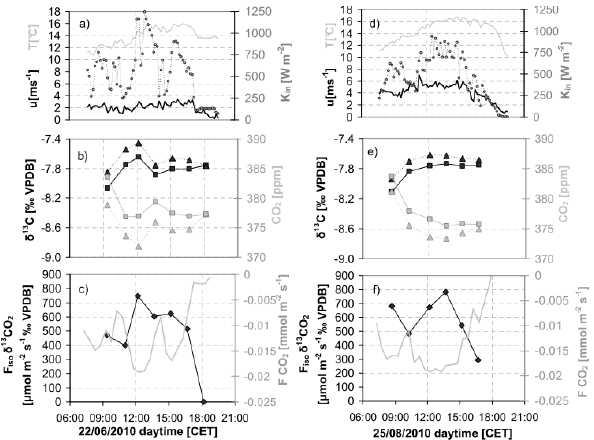
Figure 4. Incoming shortwave radiation K in (grey dashed line with circles), temperature T and wind velocity u (bold black line) are illustrated in (a) and (d) . Dark upward triangles in (b) and (e) repre- sent isotopic composition of updraft, dark squares represent that of downdraft CO 2 , and bright symbols represent CO 2 mixing ratios. (c) and (f) show the δ 13 CO 2 isoflux ( F ISO ), dark diamonds, set in the middle of the 40min measurement interval; bright lines show the CO 2 flux.